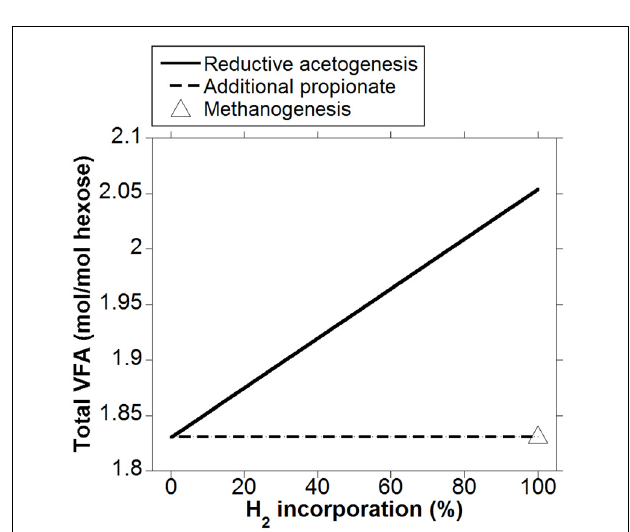
FIGURE 4 | Response of total VFA production to H 2 incorporation into reductive acetogenesis or additional propionate formation. Corresponding fermentation with CH 4 as main electron sink is provided as